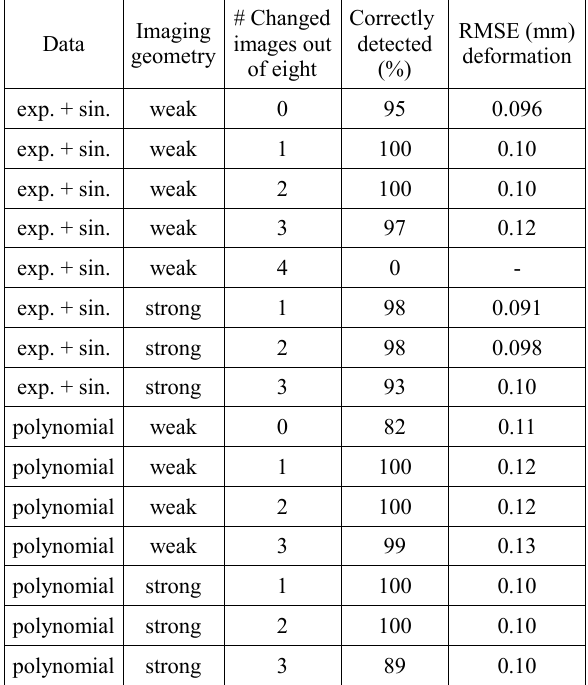
Figure 1. Percentages of trials where the image of changed orientation was correctly detected as a function of perturbation in the shape function parameters for various changes in the orientation with a) weak and b) strong imaging geometry.